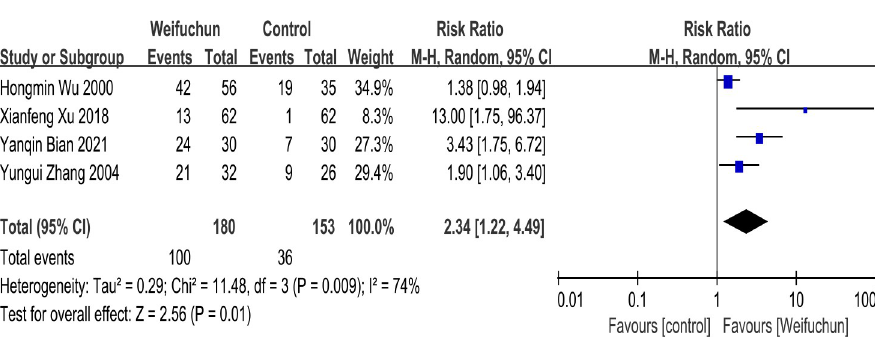
Fig 8. Forest plot of improvement of histopathologic variations of the gastric mucosa.